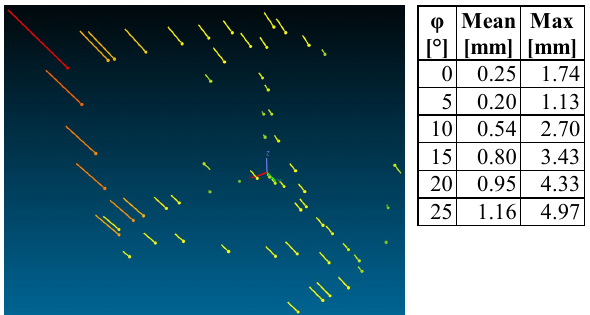
Figure 6. 3D error vectors (exaggerated by factor 230) of forward intersected 3D points of one exemplary image pair (dataset 2 MM -20°-1/99) using the calibrated parameters of interior and relative orientation. The mean and max values of the 3D errors are depicted in the table for each convergent dataset ( φ =0° to 25°).